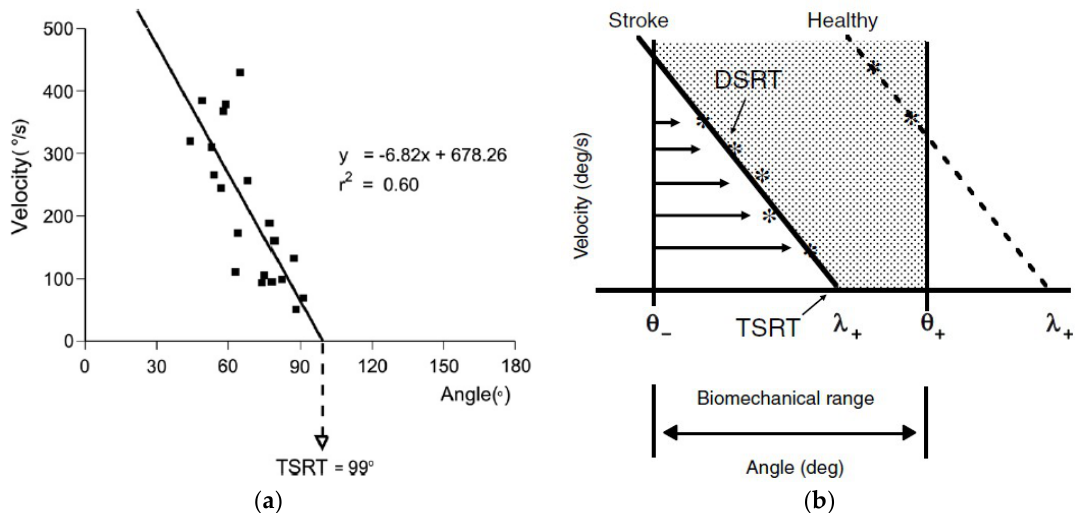
Figure 5. ( a ) Example of tonic stretch reflex threshold (TSRT) estimation by 20 dynamic stretch reflex threshold (DSRT) points found by stretching the elbow flexor muscle biceps brachii at different velocities; ( b ) example of a threshold model for a post-stroke subject versus healthy person, where the TSRT lies outside the biomechanical range of the joint [43].